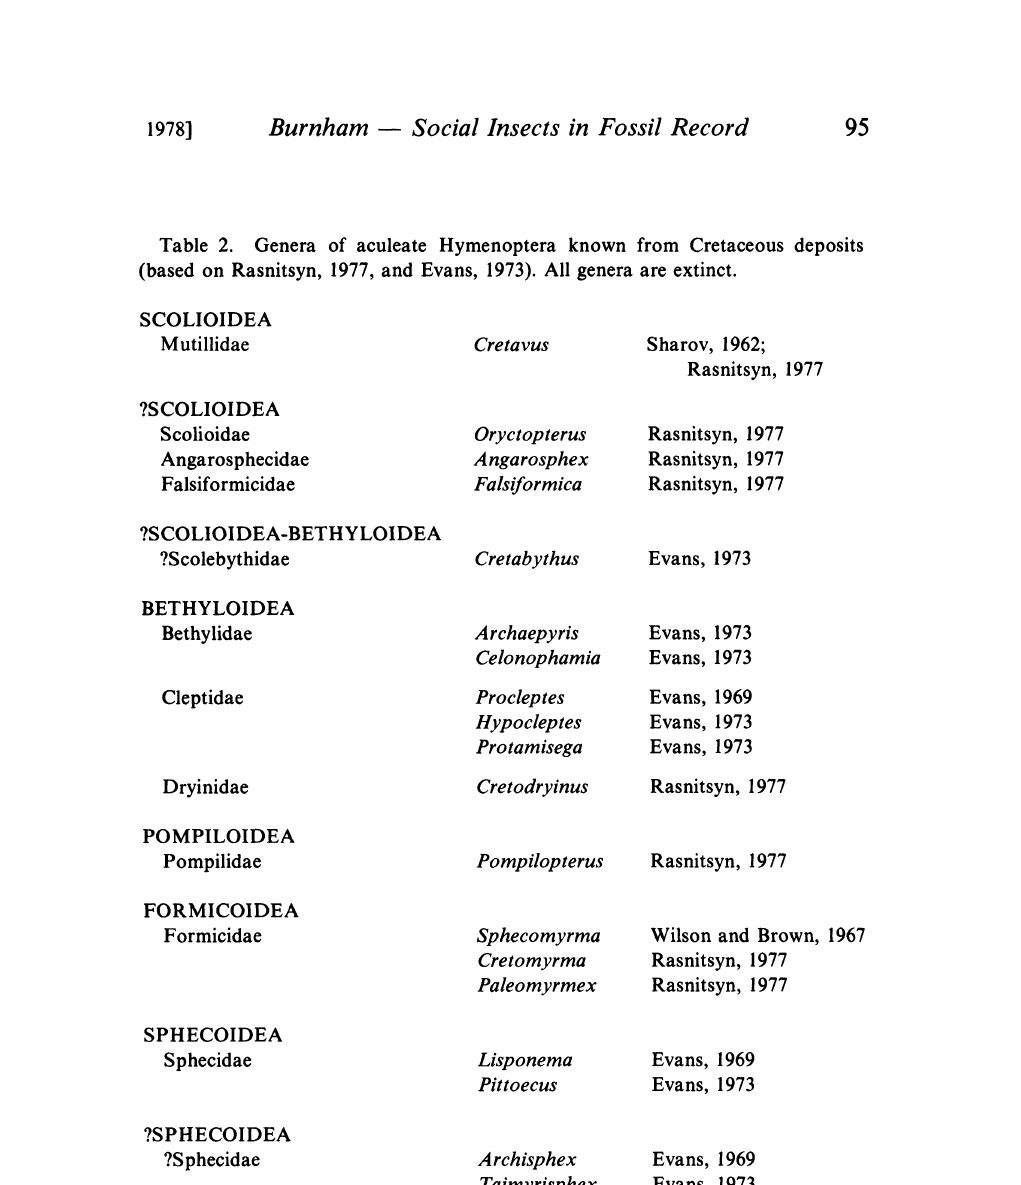
Table 2. Genera of aculeate Hymenoptera known from Cretaceous deposits (based on Rasnitsyn, 1977, and Evans, 1973). All genera are